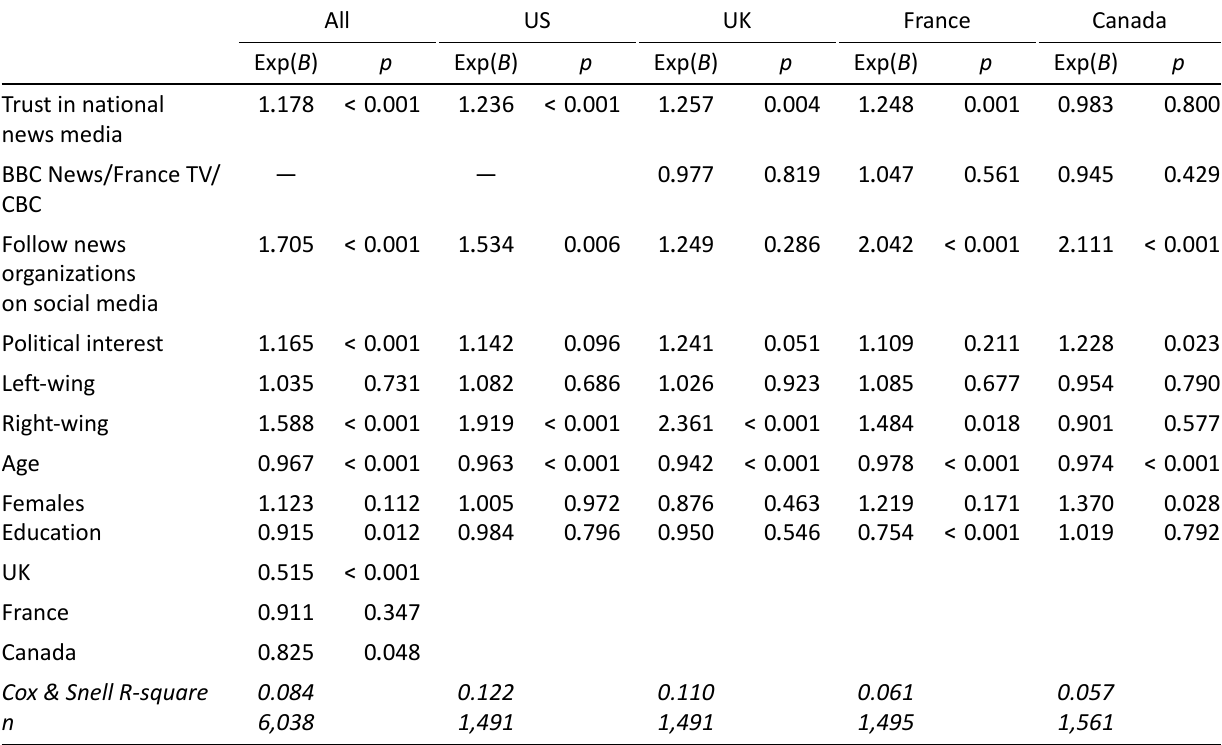
Table 5. Logistic regression of sharing misinformation (any topic). All US